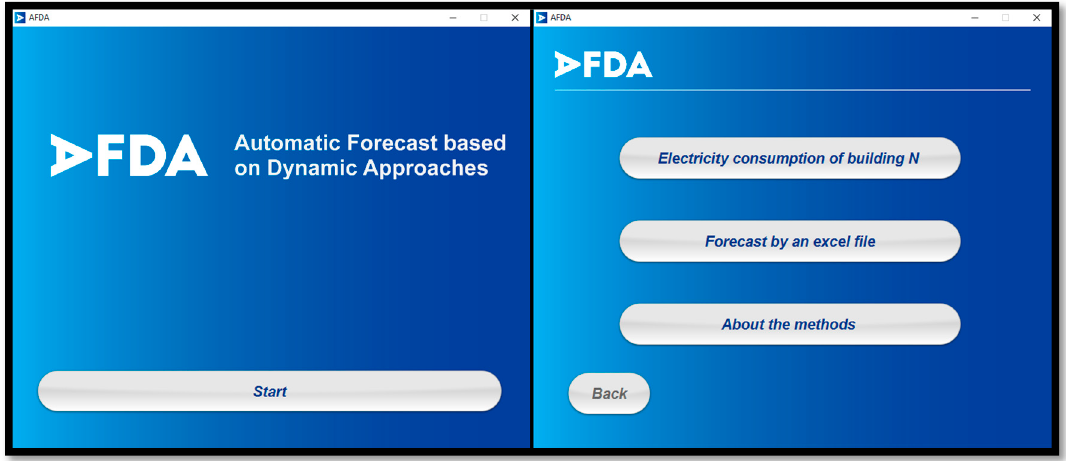
Figure 8. The principal page and menu of the application.